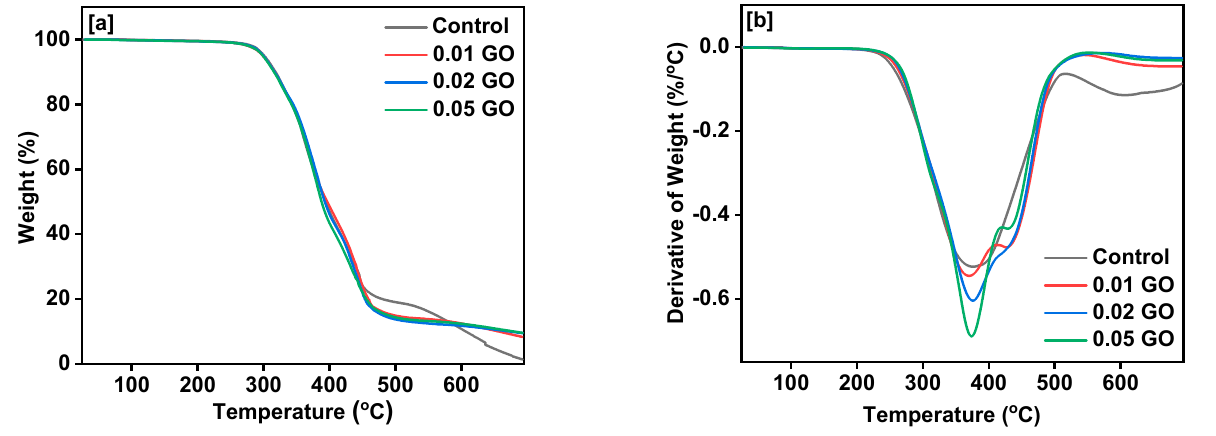
Figure 3. XRD patterns of GO and rGO.